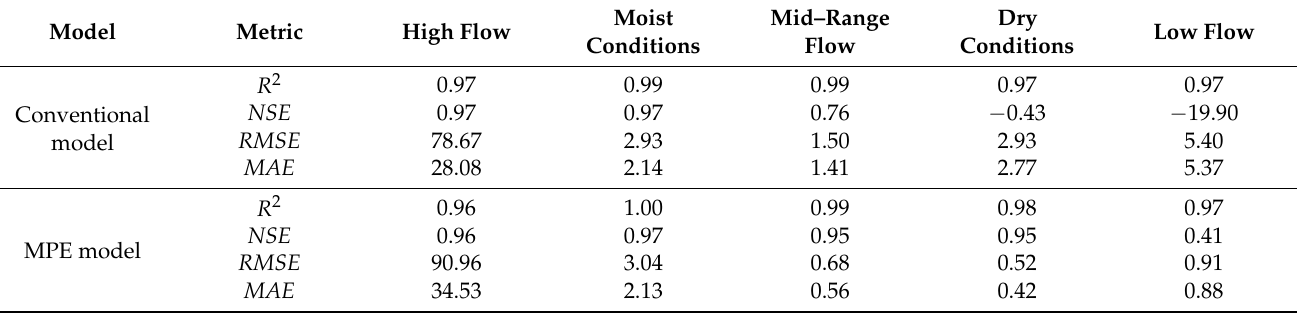
Table 5. Comparison of performance of both models for flow